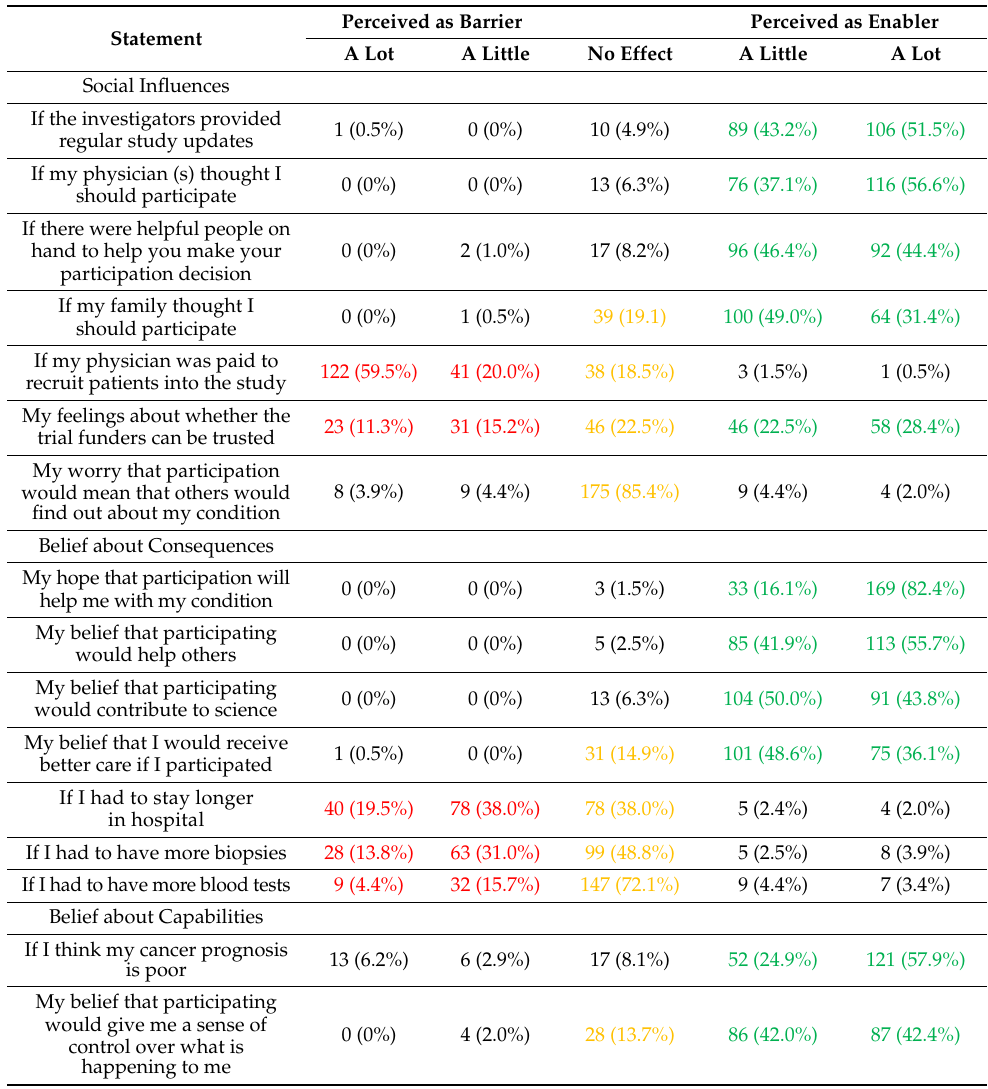
Table 3. Barriers and enablers to participation in a hypothetical trial of a new treatment for breast cancer ( N = 210) N (%). Perceived as Barrier Perceived as Statement